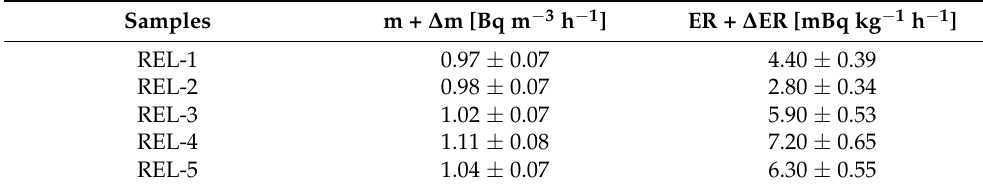
Table 4. Slope and radon mass exhalation rate in mining tailing